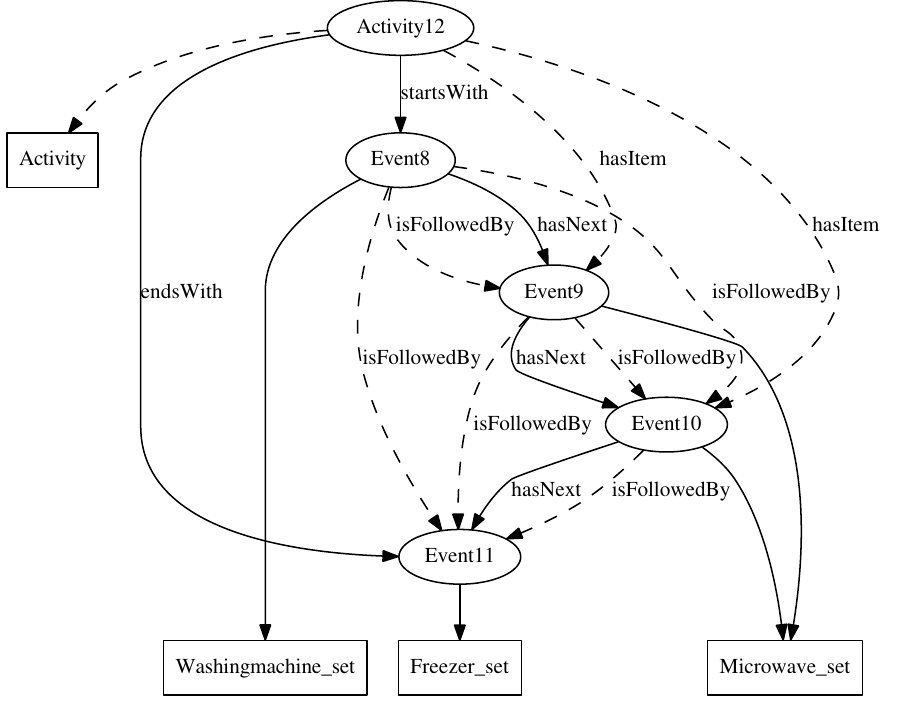
Figure 1. Ontology